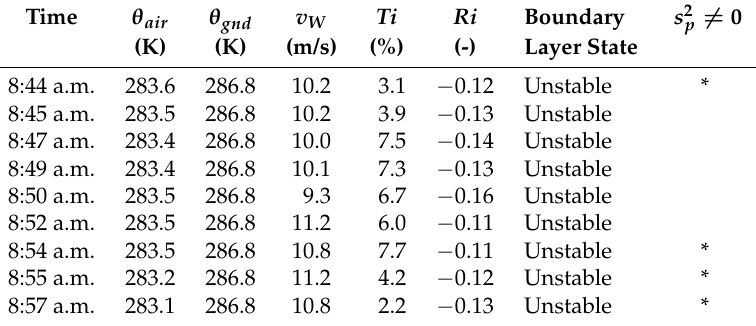
Table 2. Development of Time Series on October 19. Potential temperatures ( θ ), wind speeds ( v W ) and turbulence intensities ( Ti ) from cup anemometers, Ri numbers, and estimated ABL states. Time θ